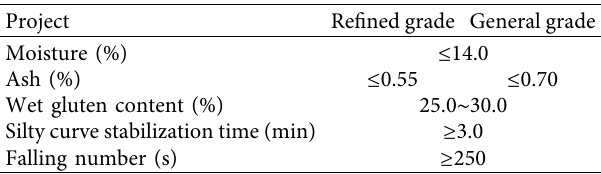
Table 2: Standard for wheat flour for steamed